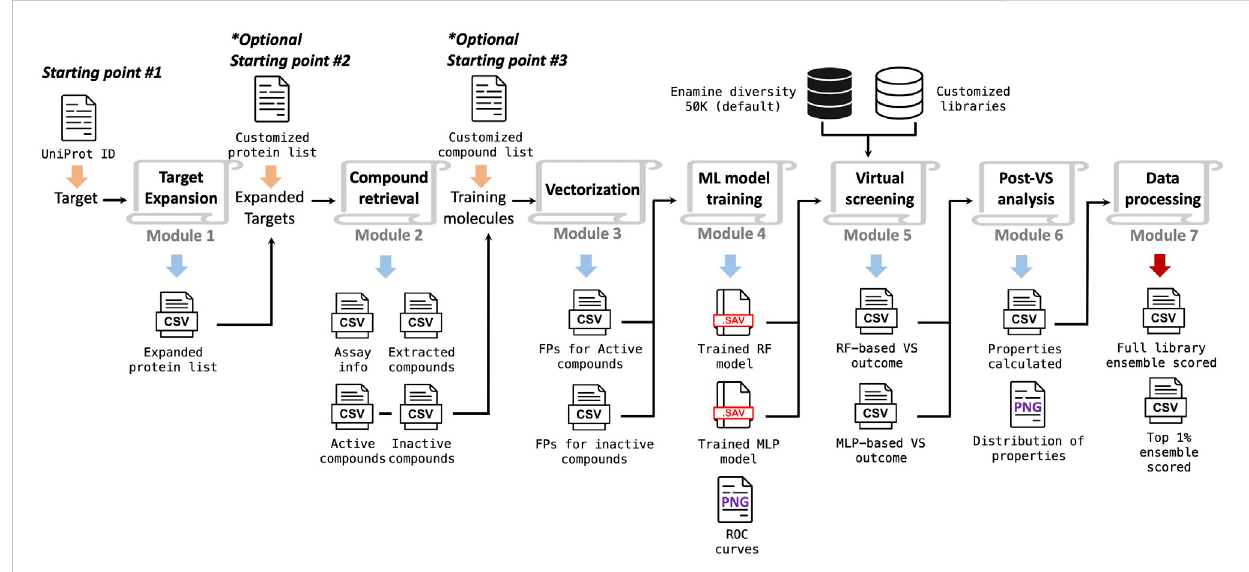
FIGURE 1 Scheme of the work fl ow implemented in the target-driven, ML-enabled VS